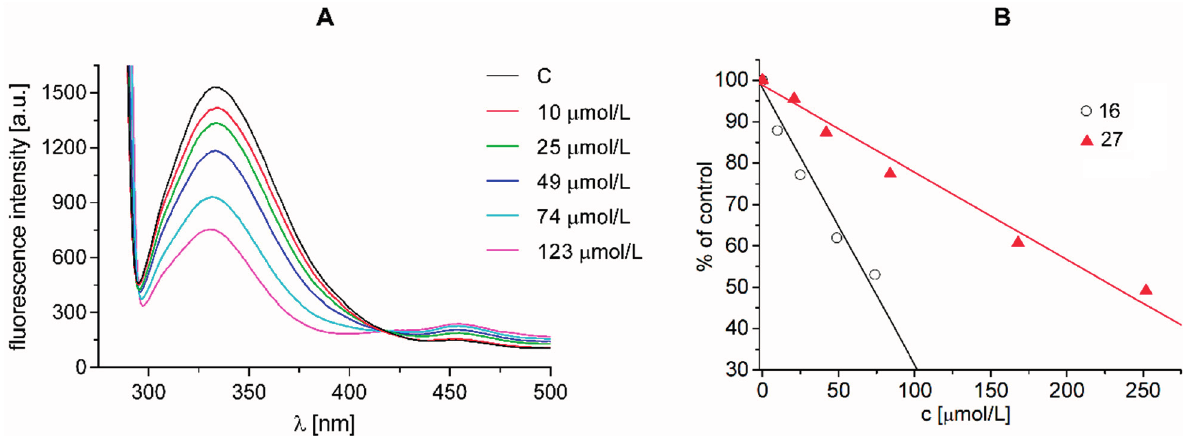
Figure 5. ( A ) Fluorescence emission spectra of aromatic amino acids in suspension of spinach chloroplasts without and with compound 16 (c = 0, 10, 25, 49, 74 and 123 μ mol/L; the curves from top to bottom); ( B ) Dependence of intensity of aromatic amino acids fluorescence emission band (expressed as % of control) at 340 nm in suspension of spinach chloroplasts on the concentration of studied compounds: 27 and 16 . Excitation wave length λ = 275 nm; chlorophyll concentration 10